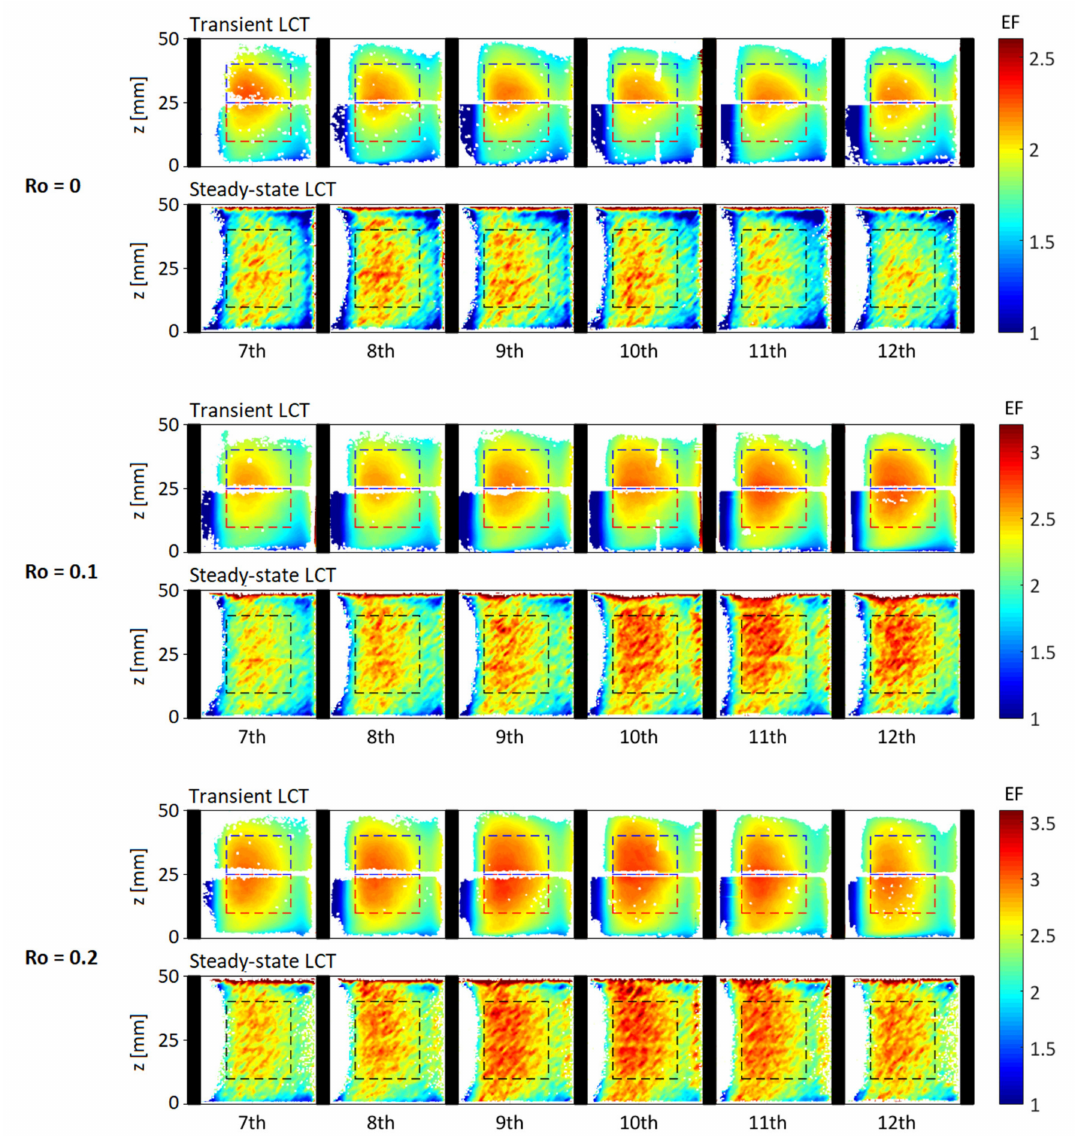
Figure 12. Enhancement factor